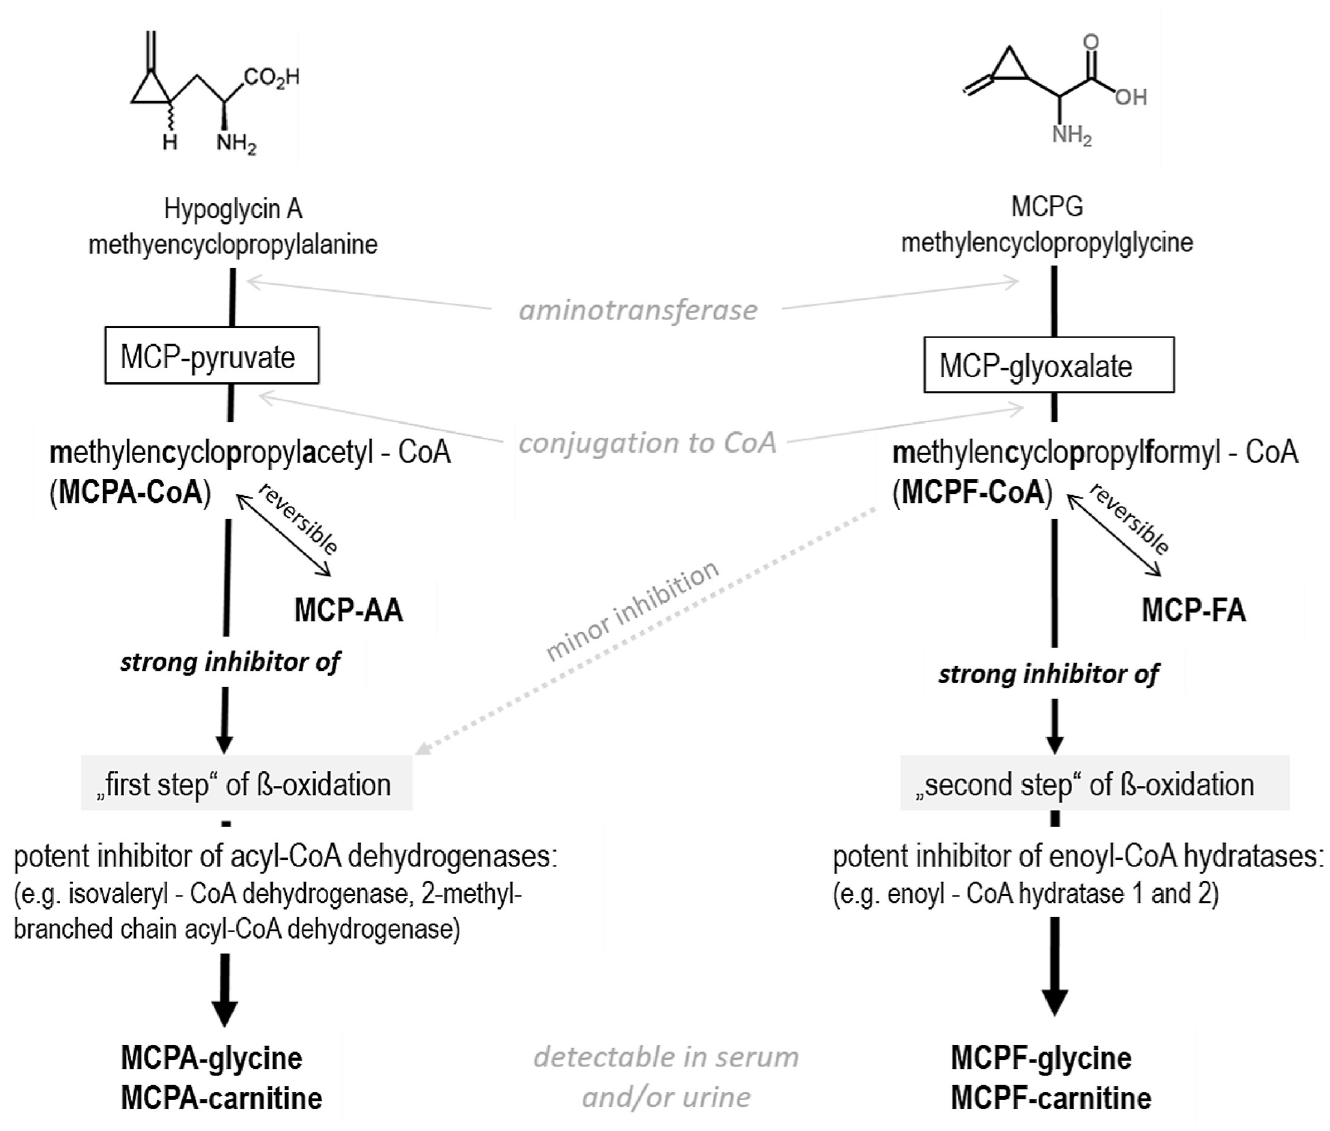
Fig 1. Metabolic pathway for MCPG and HGA after ingestion and possible mechanisms of